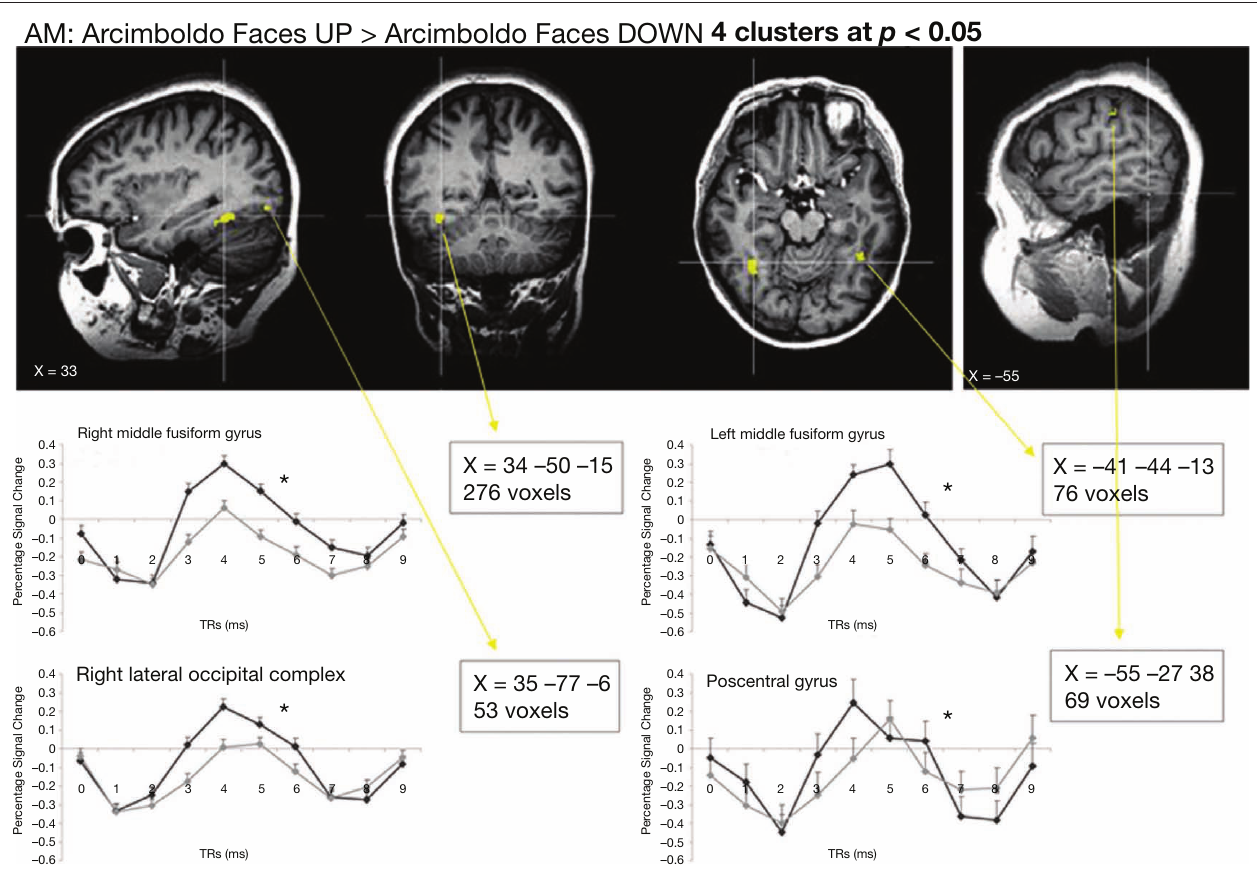
localizer experiment ( p < 0.000007), one close to the right “OFA” or to the right ventral posterior part of LO [35, − 77, − 6, 53 voxels, object-sensitivity: t = 15.04, p < 0.000001 presenting a small face-preferential response ( p < 0.01)] and another non-face region, in the postcentral